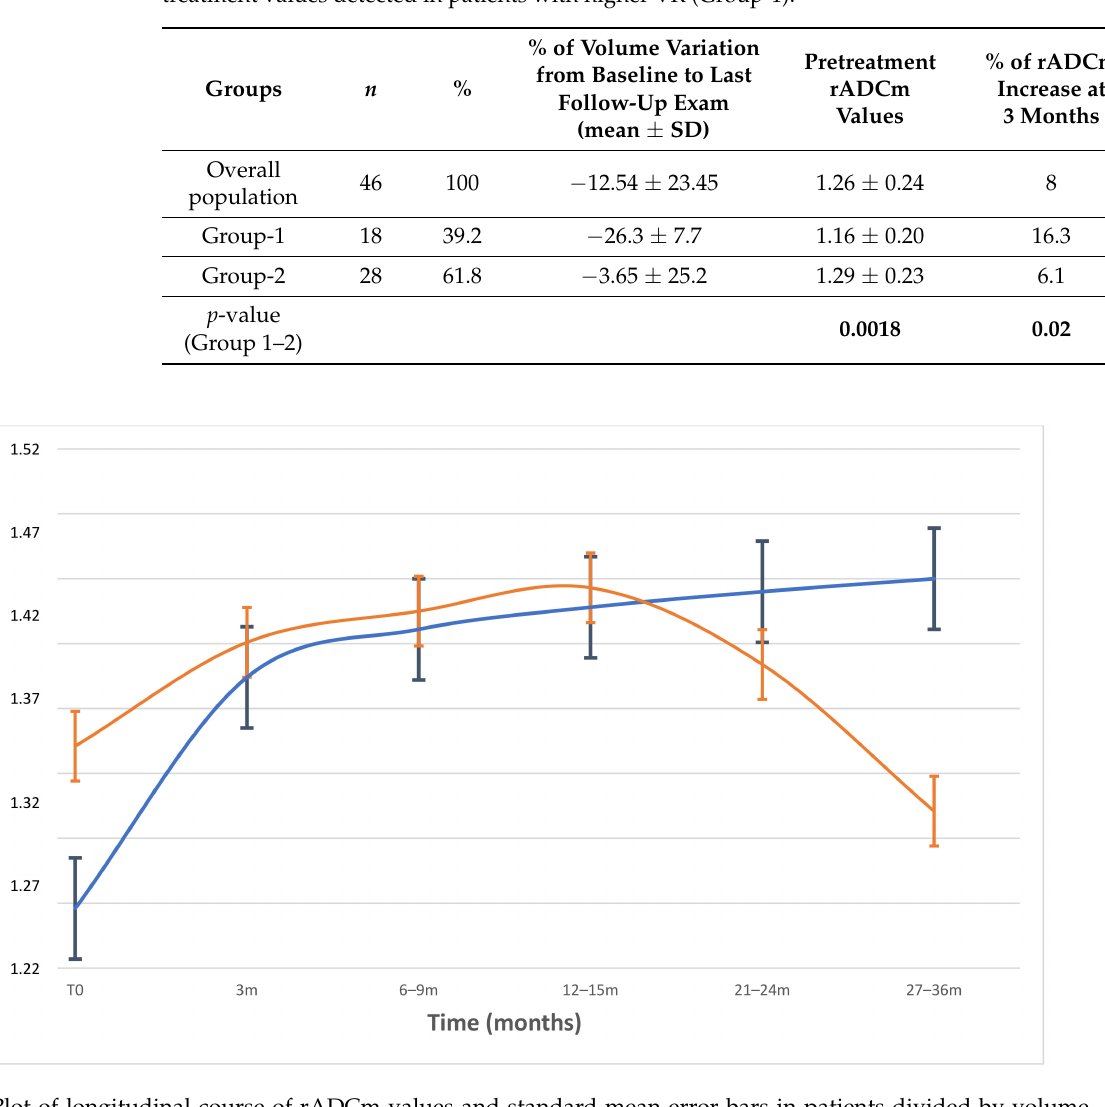
Figure 3. Plot of longitudinal course of rADCm values and standard mean error bars in patients divided by volume variation percentage (VV; threshold − 20%). In patients with VV > − 20% (blue line), rADCm levels increased continuously and showed significant differences from baseline to each FU ( p < 0.001). In patients with lower VV < − 20%) (orange line), rADCm values did not change significantly to baseline, showing a progressive reduction after 12–15 months